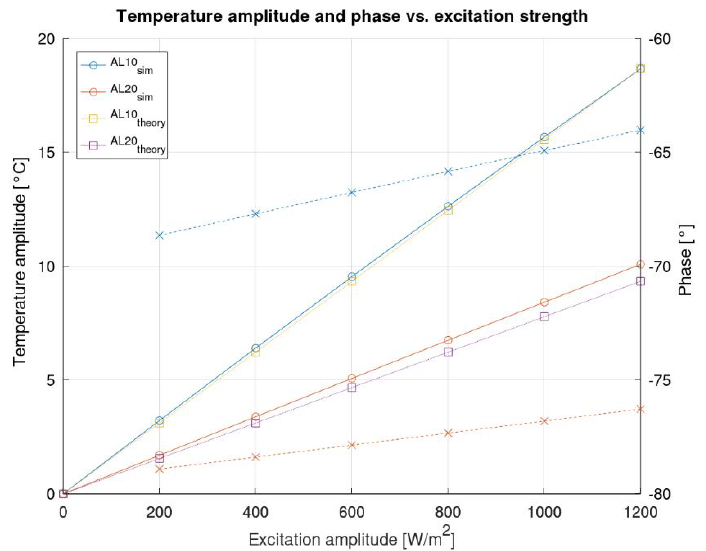
Figure 1. Amplitude and phase angle of the temperature signal from the thermal simulation in comparison to the analytical formula (cf. Equations (1) and (2)). The dotted line shows the phase angle and the solid line the temperature amplitude. Depicted here are temperature amplitudes and phase angles calculated by the FFT in relation to heat input density.